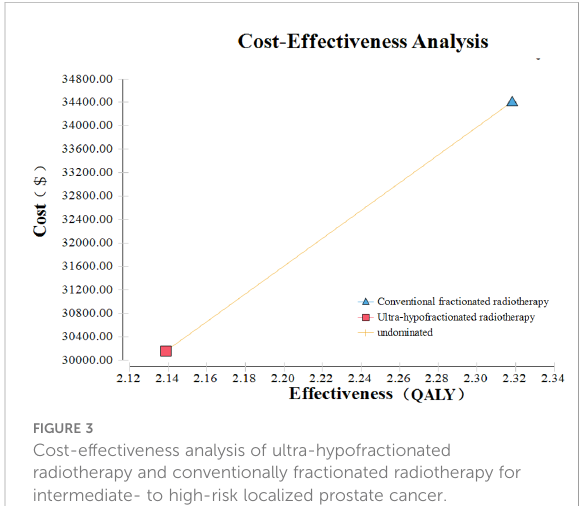
FIGURE 3 Cost-effectiveness analysis of ultra-hypofractionated radiotherapy and conventionally fractionated radiotherapy for intermediate- to high-risk localized prostate